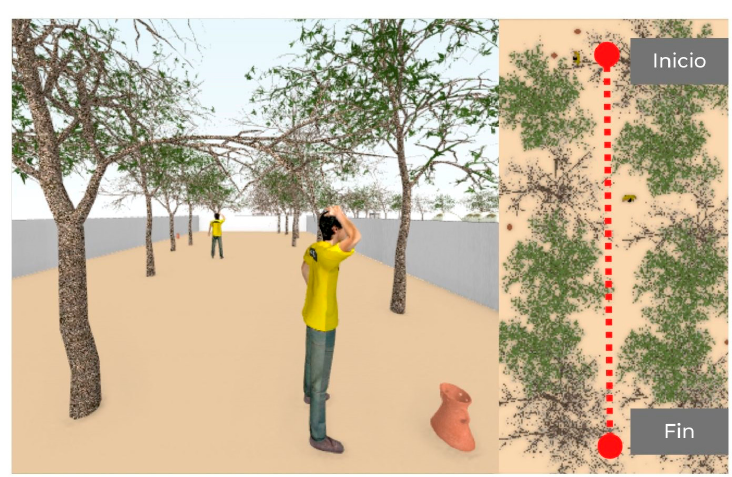
Figure 4. “Mayanshi supay allpamanka” game.